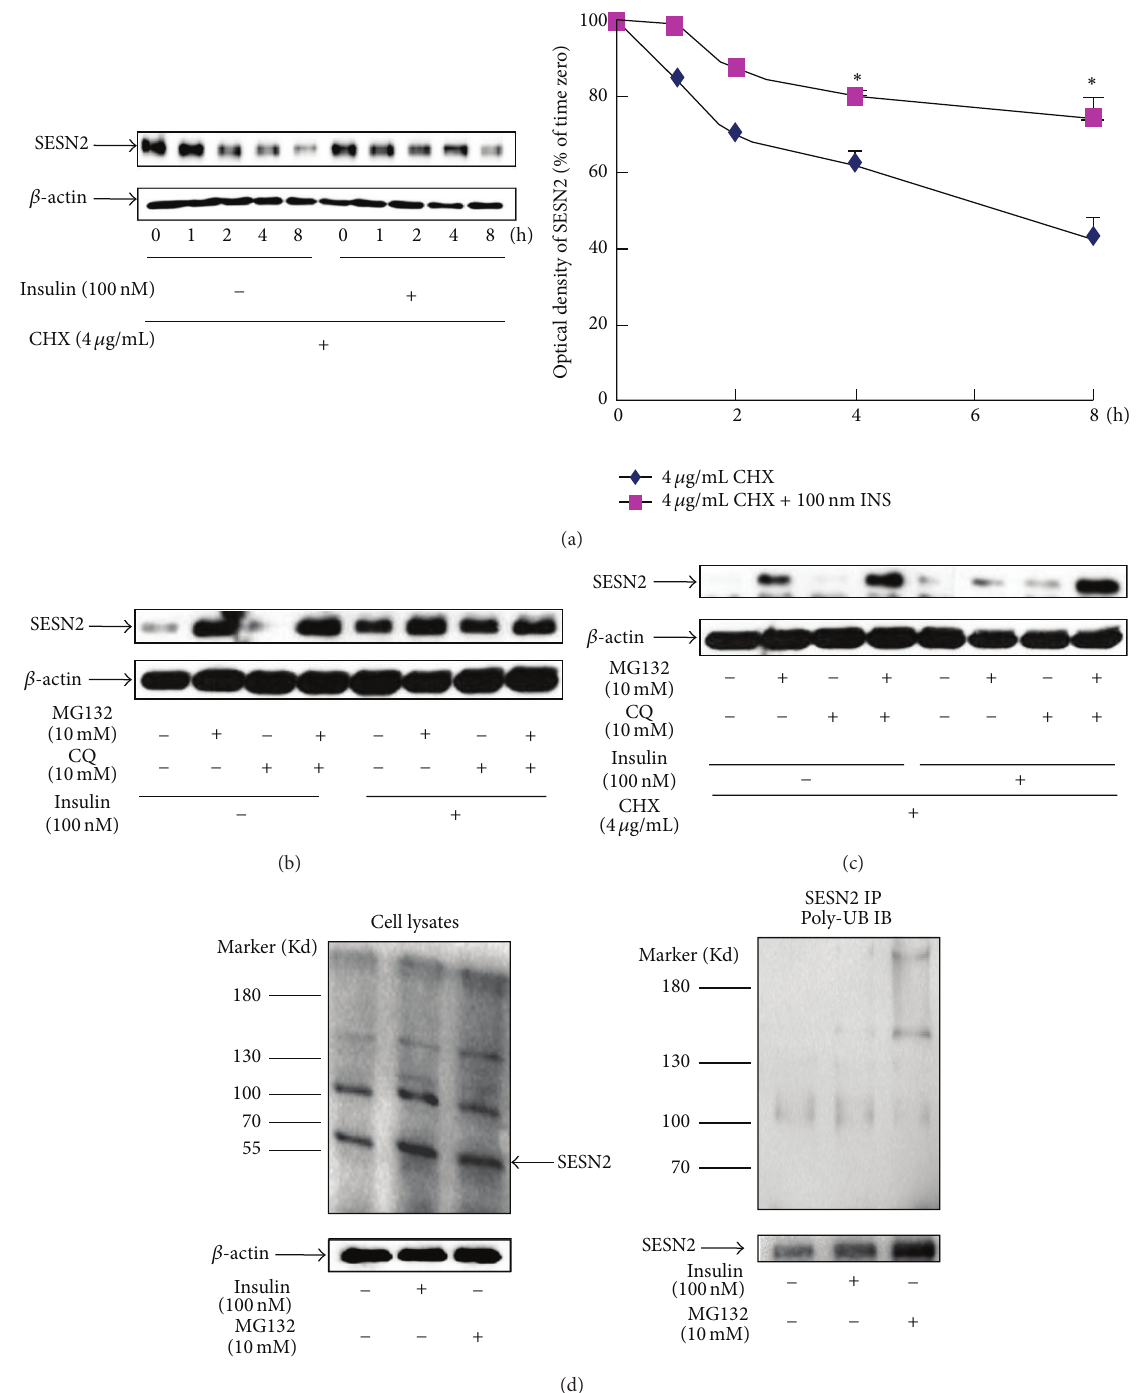
Figure 3: Insulin or the proteasomal inhibitor MG132 blocks SESN2 degradation. (a) HepG2 cells were pretreated with CHX for 30 min followed by a treatment with or without 100 nM of insulin (INS) for the indicated times. The cells were then lysed for SESN2 western blotting. Right panel is the plot of densitometric analysis. ∗ 𝑃 < 0.05 compared with noninsulin treatment. (b) and (c) HepG2 cells were treated with the indicated reagents for 30min, followed by a treatment with or without 100nM insulin for 8 h. The cells were then lysed for SESN2 western blotting. (d) HepG2 cells were incubated with or without insulin or MG132 for 18 h and the cells were lysed. Western blotting of SESN2 and 𝛽 -actin (loading control) of total cellular proteins (left panel) or SESN2 immunoprecipitation followed by polyubiquitin antibody western blotting (right panel). IP indicates the immunoprecipitation antibody; IB indicates the immunoblotting antibody. Bottom panel of left panel: western blotting of the input samples. A representative blot of three independent